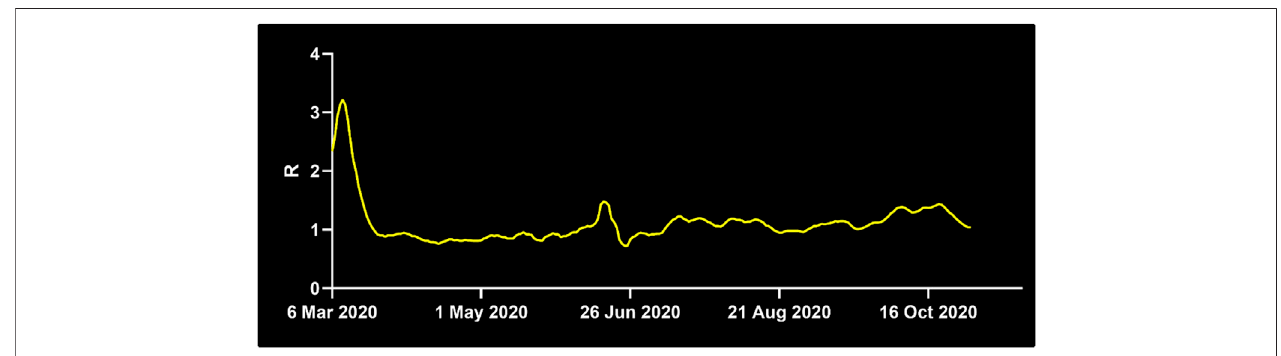
FIGURE 3 | Development of the basic reproductive number R 0 in Germany. While R 0 was at 1.3 on April 7th, 2020, it decreased below the critical value of R 0 (cid:1) 1 shortlyafterApril7thuntilJune21st,whereitsurgedto2.03.Forthemajorityoftimethereafter,R